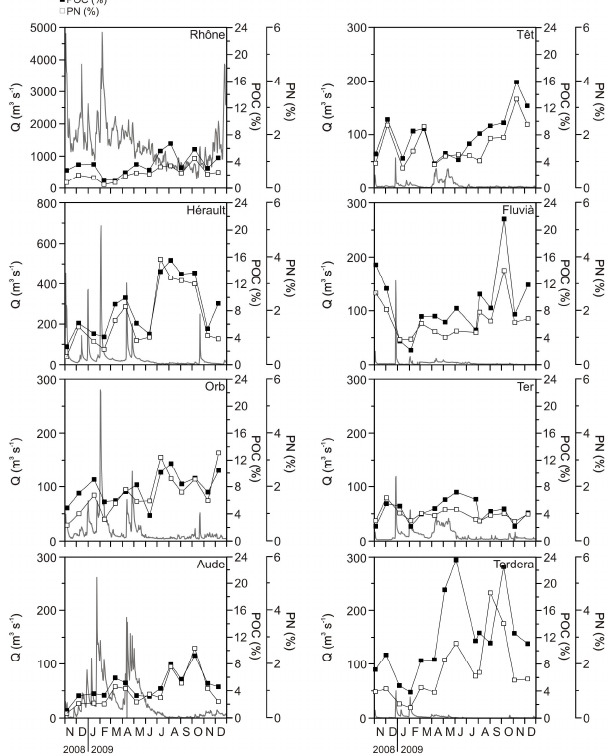
Figure 3. Temporal variability of particulate organic carbon (POC) and nitrogen (PN) 843 Fig. 3. Temporal variability of particulate organic carbon (POC) and contents (in percentage) with the corresponding average daily water discharges (Q) of the 844 nitrogen (PN) contents (in percentage) with the corresponding av- eight studied rivers from November 2008 to December 2009. 845 erage daily water discharges ( Q ) of the eight studied rivers from November 2008 to December